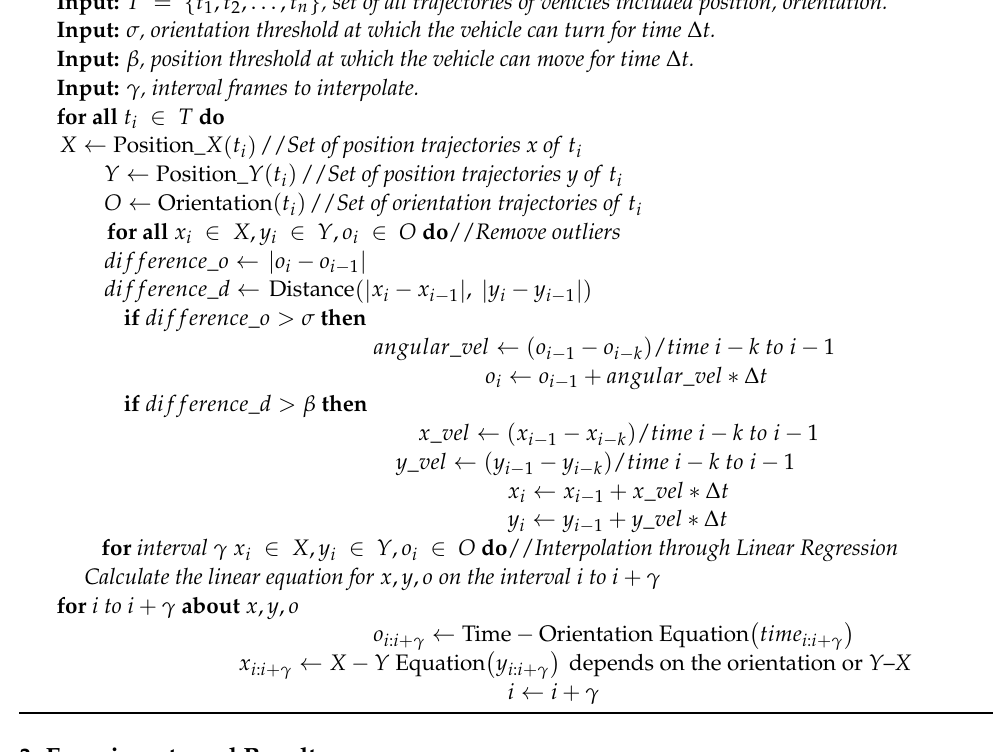
Algorithm 2. Trajectory correction using linear regression and